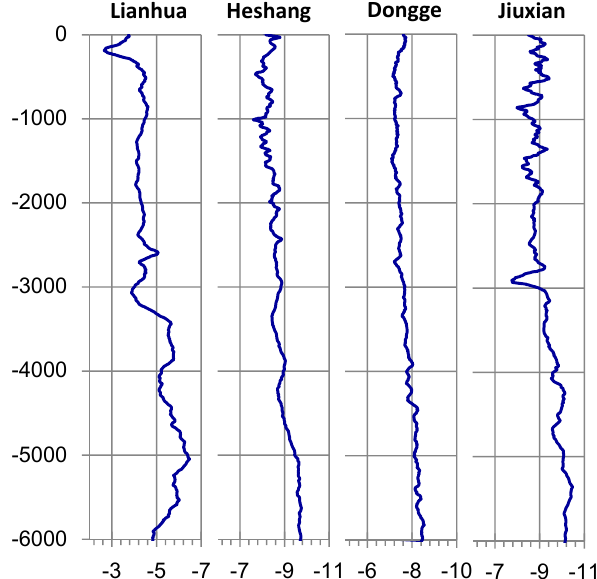
Figure 8. Reconstructed speleothem oxygen isotope records ( d 18 O, per mil) taken from different caves in the East Asian monsoon re- gion (cf. Fig. 1), i.e.: Lianhua Cave (29.29 ◦ N, 109.32 ◦ E; Cosford et al., 2008), Heshang Cave (30.45 ◦ N, 110.42 ◦ E; Hu et al., 2008), Dongge cave (25.32 ◦ N, 108.09 ◦ E; Wang et al., 2005), and Jiuxian Cave (J, 33.34 ◦ N, 109.6 ◦ E; Cai et al., 2010).